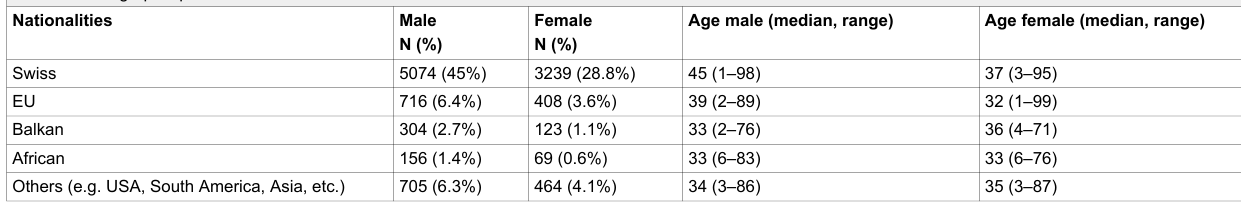
Table 3 Clinical diagnosis of sample-patients (n =